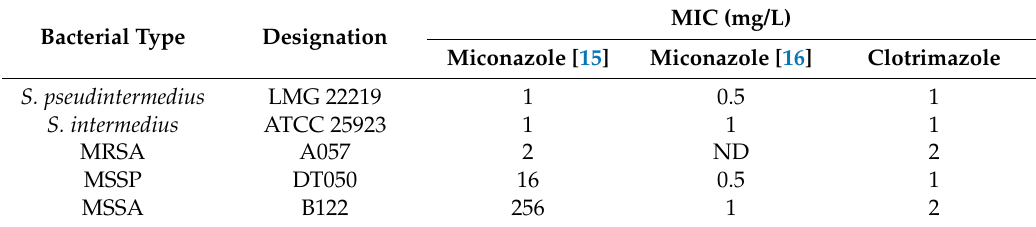
Table 2. MICs (mg/L) of clotrimazole and miconazole for strains/isolates of Staphylococcus aureus , S. intermedius and S. pseudintermedius used for quality control and comparative